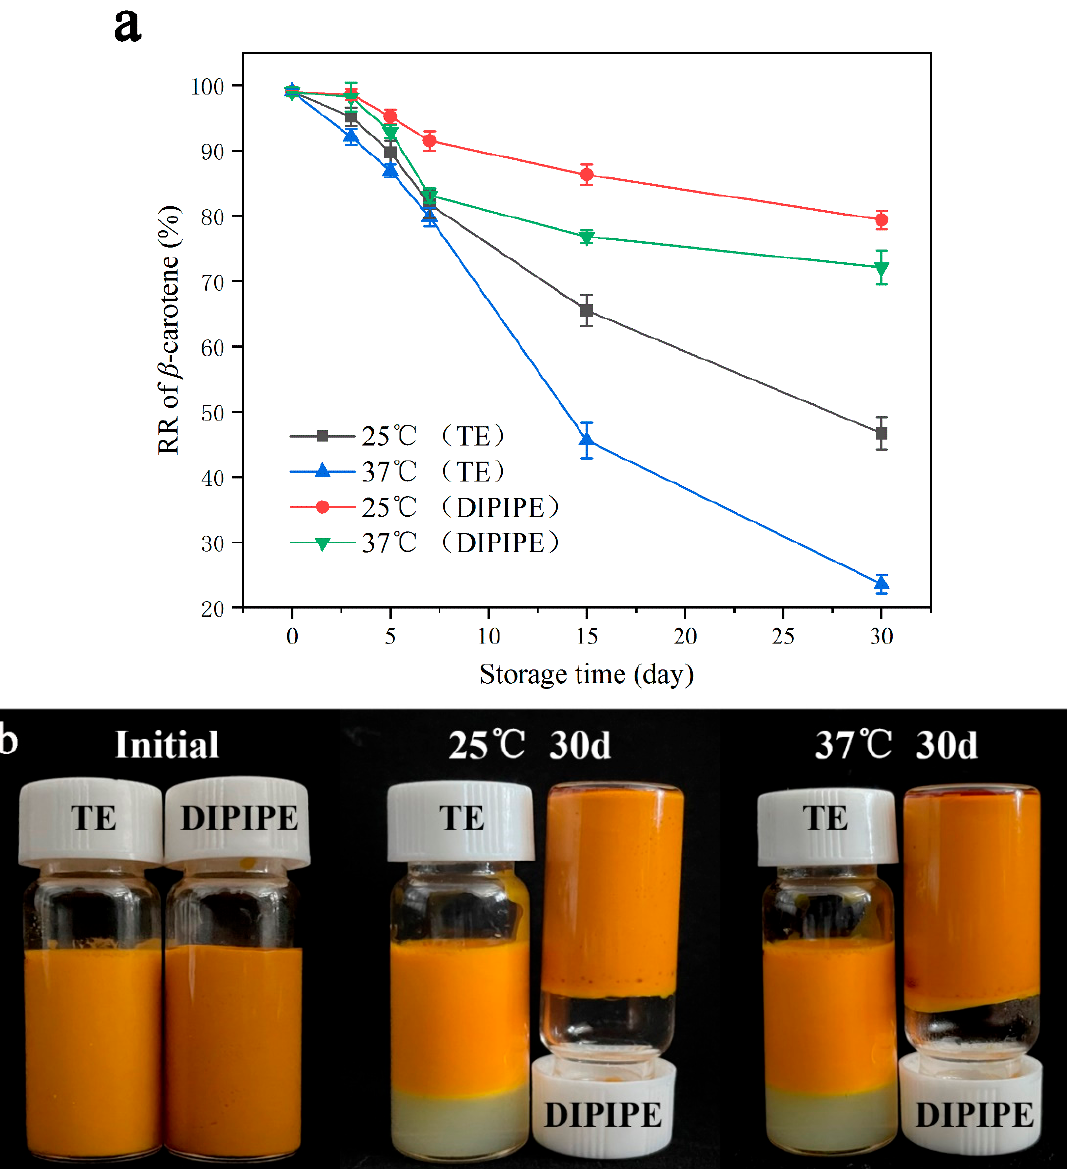
Figure 1. ( a ) Changes in β -carotene retention rate over time at different storage temperatures. ( b ) Appearance of the β -carotene emulsion after storage for 30 days at 25 ◦ C and 37 ◦ C. Comprehensive analysis indicates that compared with TE, DIPIPE could significantly improve the encapsulation efficiency and the retention rate of β -carotene, and it could more effectively delay its degradation and improve its chemical stability. The main reason is that previous laboratory studies proved that DIPIPE had a gel grid structure [18], and the thick interface layer of the Pickering emulsion could wrap the β -carotene oil phase in the grid structure. Consequently, the diffusion of β -carotene to the outer water phase is blocked, increasing the